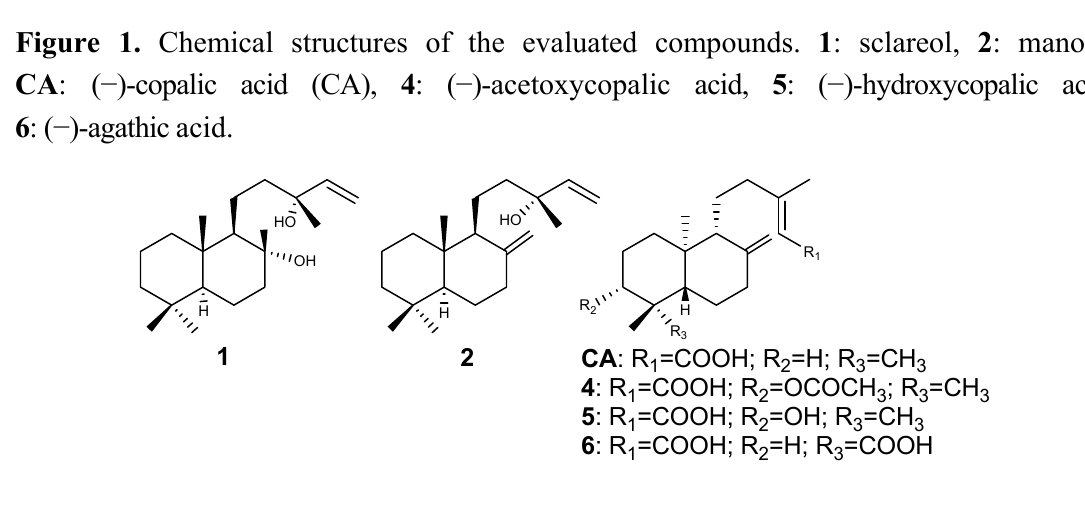
Figure 1. Chemical structures of the evaluated compounds. 1 : sclareol, 2 : manool,